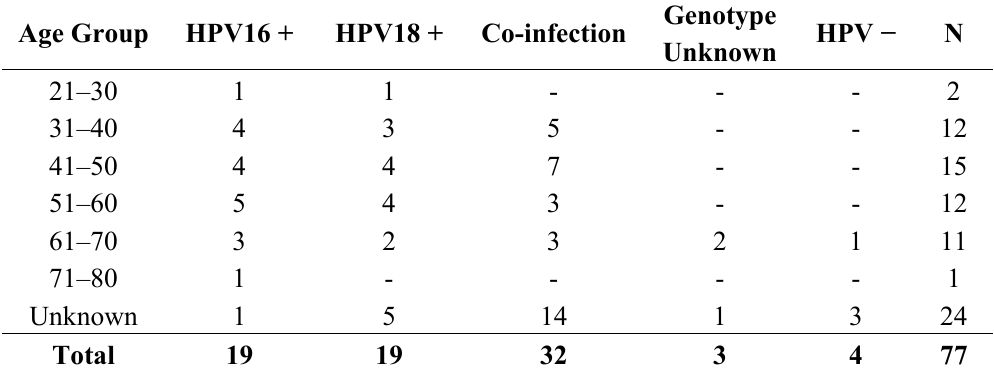
Table 4. HPV16 and 18 prevalence in cervical cancer biopsies with age distribution.